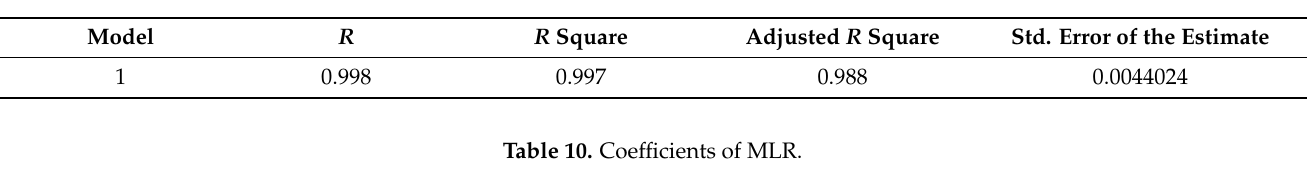
Table 9. Model summary of MLR.